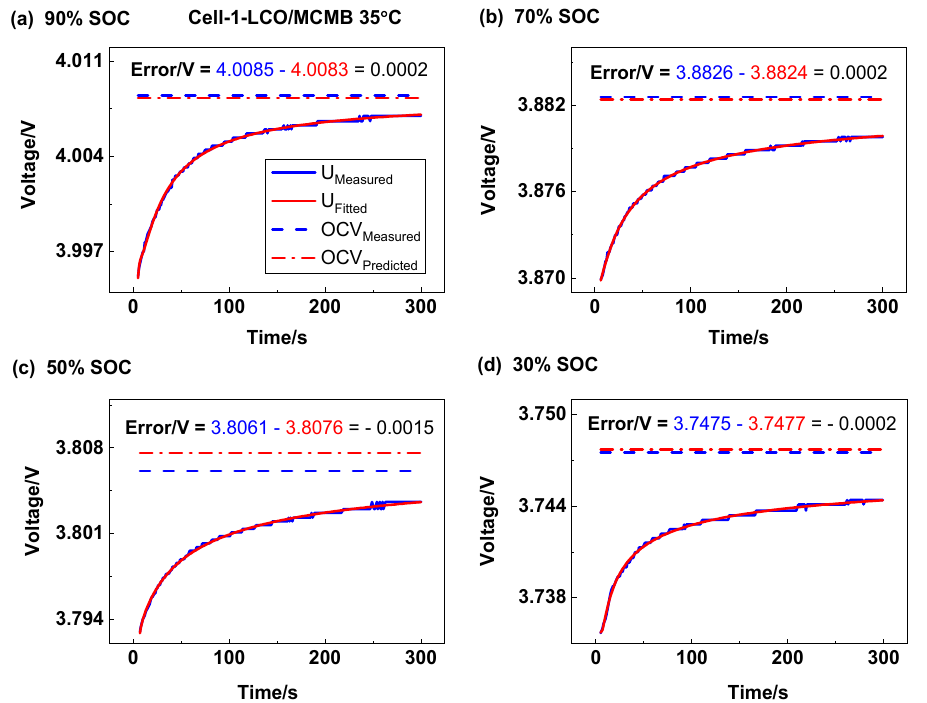
Figure 4. The measured and predicted voltage relaxation results of: ( a ) LCO/MCMB battery (Cell-1) at 70% SOC, and ( b ) LFP/Graphite battery at 80% SOC. They were discharged with 0.5 C at 35 °C before the current interruption.